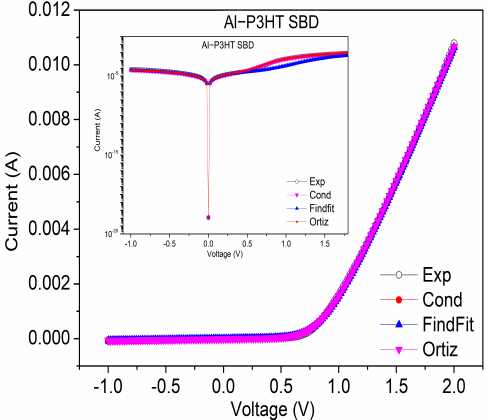
Figure 5. Experimental data and numerical characteristics obtained with the three methods for the organic-based SBD. The inset figure shows the semi-log scale for these